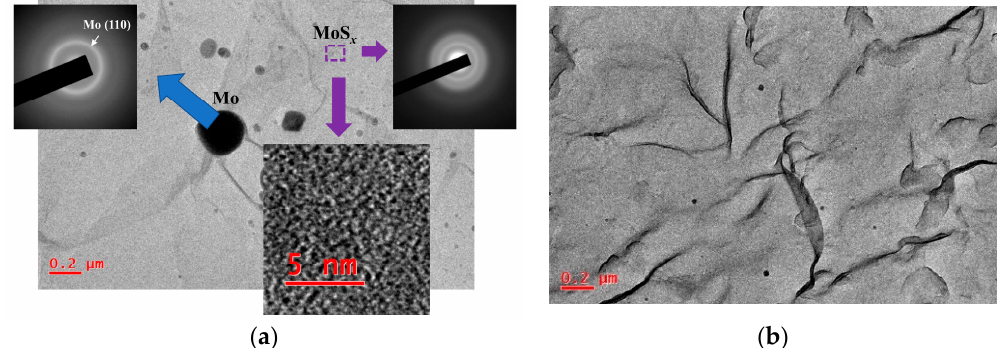
Figure 8. ( a ) TEM image and selected area diffraction (SAED) patterns of the thin MoS 4.5 film obtained by RPLD (the local area of the film that contained Mo particles was selected). The bottom insert shows high-resolution TEM image of the MoS 4.5 film. ( b ) Typical TEM image of the MoS 4.5 film, which indicates a low content of Mo particles embedded in this film.